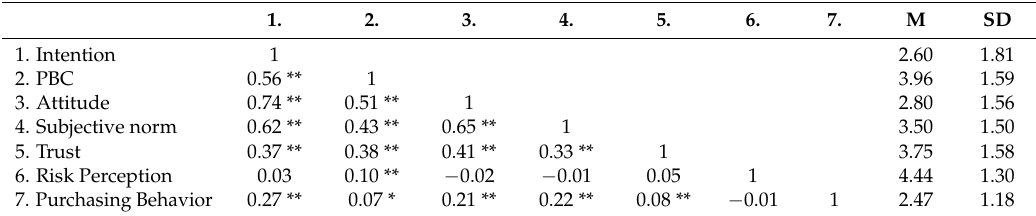
Table 3. Descriptive finding and correlations between study variables.